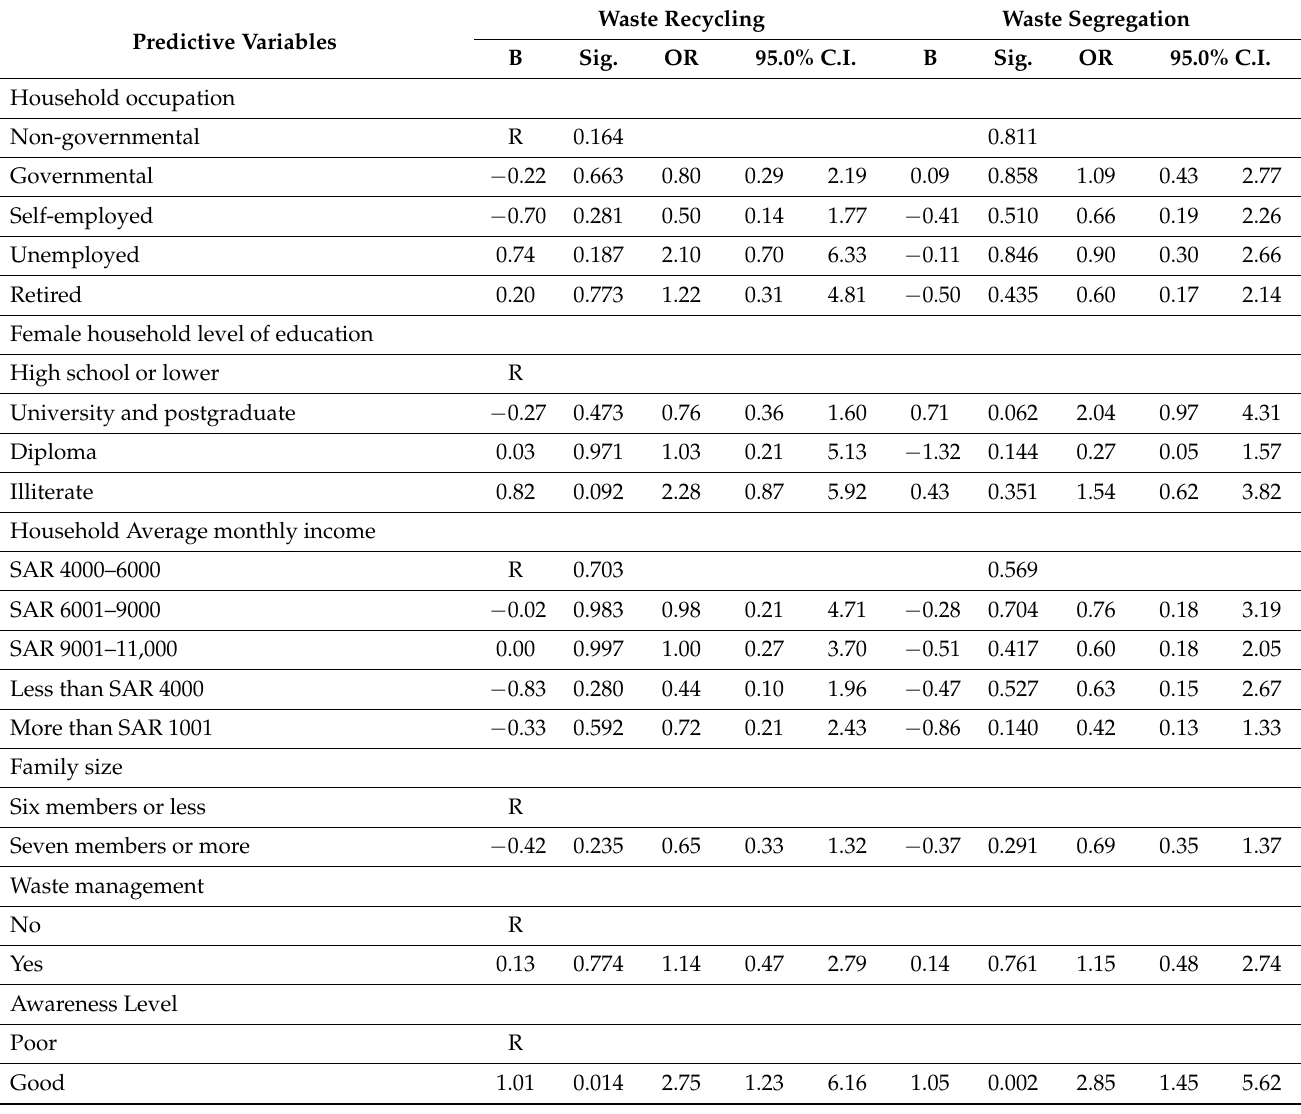
waste generated by male and female-headed households in the study was plastic (45.5%). The remaining types of waste reported were paper (15.4%), glass (12.9%), food waste (10.1%), textiles (old clothes) (8.6%), and battery and electronic waste (3.9%), as seen